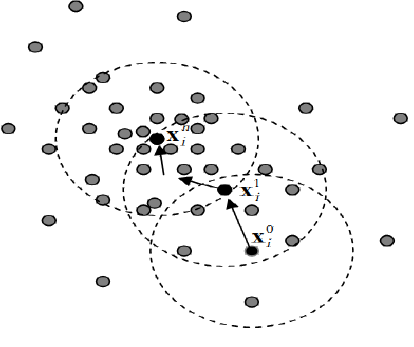
Figure 6. Mean shift procedure (Derpanis,